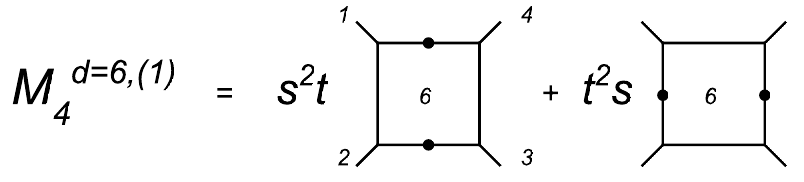
Figure 6 . The one loop amplitude candidate in d =